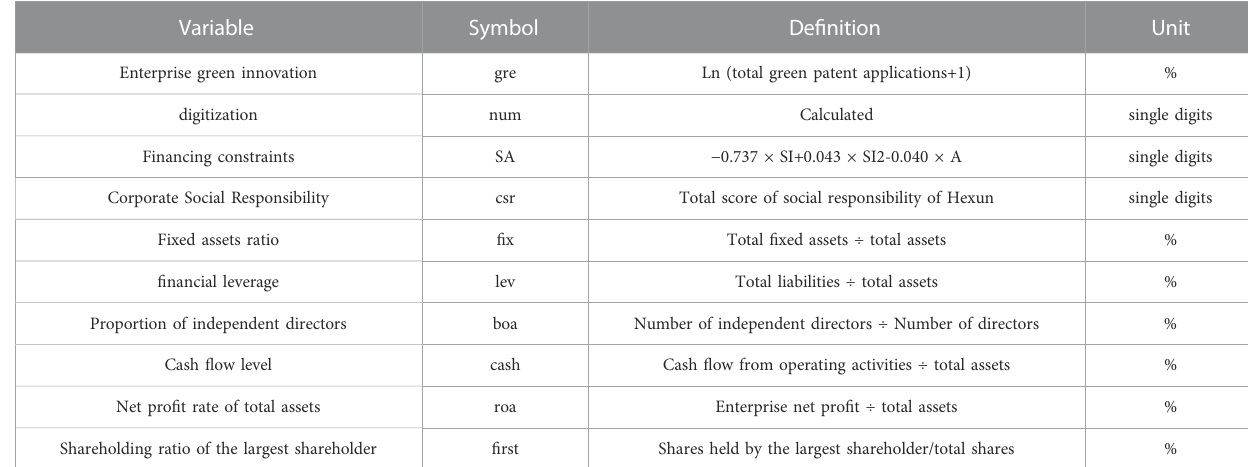
TABLE 1 Variable de fi